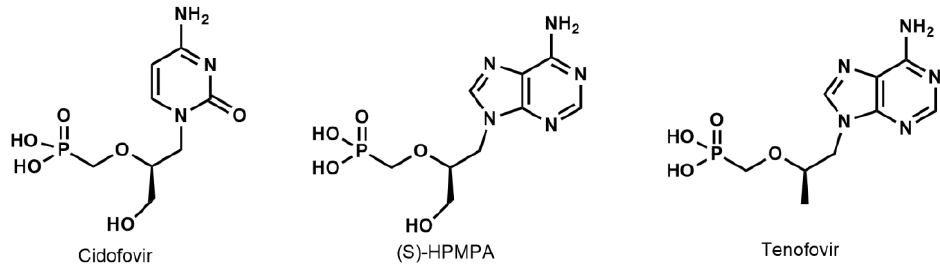
Figure 1. Examples of acyclic nucleoside phosphonates (ANPs) with antiviral activity.